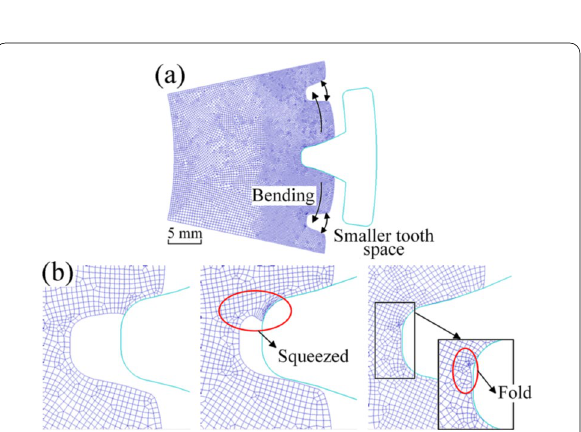
Figure 6 The formation of fold in the third pass of Scheme 2-4: (a) the smaller tooth spaces and bending tooth, (b) materials on sides of the tooth is squeezed and form the